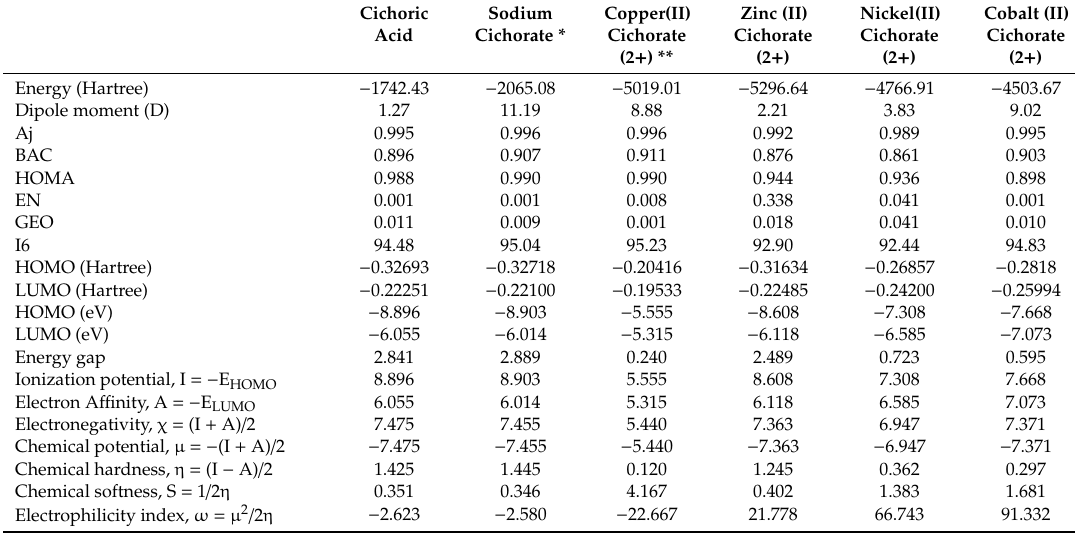
Table 2. Geometrical parameters calculated in HF / 6-311 ++ G(p,